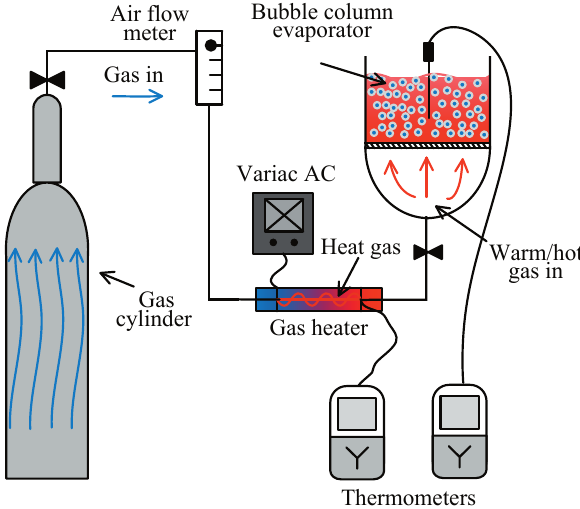
Figure 2. Schematic diagram of the bubble column evaporator (BCE) for solute decomposition. (Reprinted with permission from Ref. 3. Copyright 2015 American Chemical